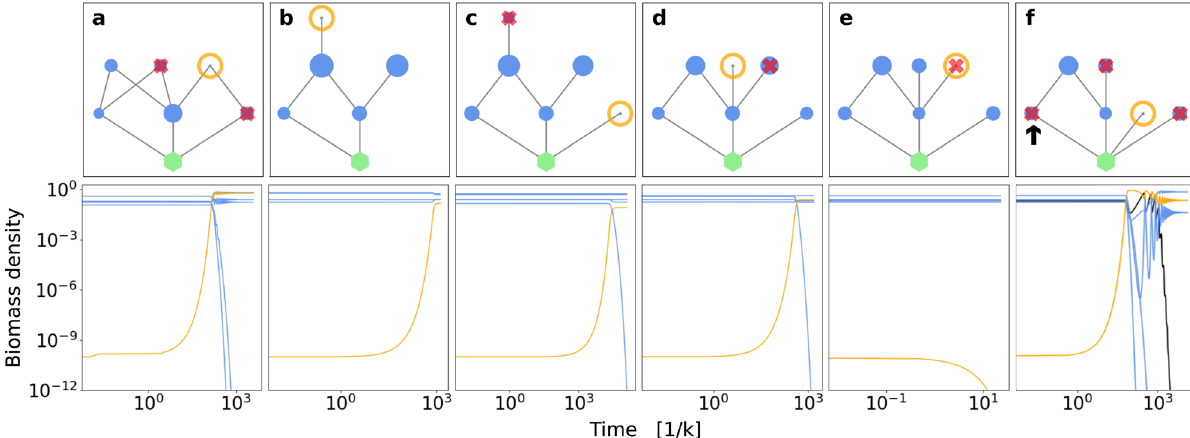
Figure 2. Time series of a food web during several invasions. The panels ( a – f ) respectively correspond to invasion attempts 40312–40314, and 40316–40318 in Fig. 1c. Upper row : In each panel, orange circles and red “ x ”-symbols denote the invasive and extinct species, respectively. The vertical coordinate denotes trophic level, and node areas represent initial biomass densities. The green hexagon represents the basic nutrient source. ( a ) A species successfully invades the food web, but causes the extinction of two resident species, among these one of its own resources. ( b ) the invader is successful without causing any extinctions. ( c ) The invader is a primary producer and causes extinction of the invader from ( b ). ( d ) The invader replaces a resident species of same niche as the invader. ( e ) The invader is unsuccessful in invading the food web as it shares a niche with one of the resident species. ( f ) The invader is a primary producer and causes the extinction of three resident species, among these the primary producer with lowest decay rate, corresponding to largest intrinsic fitness, which is highlighted by the black arrow. Lower row : Time series corresponding to each of the food webs above, where 1 time is measured in units of the inverse primary producer growth rate, k − . Blue and orange lines represent resident and invasive species, respectively, as the new steady state is approached. The black line in the last panel represents the producer with lowest decay rate. Note the double-log axis